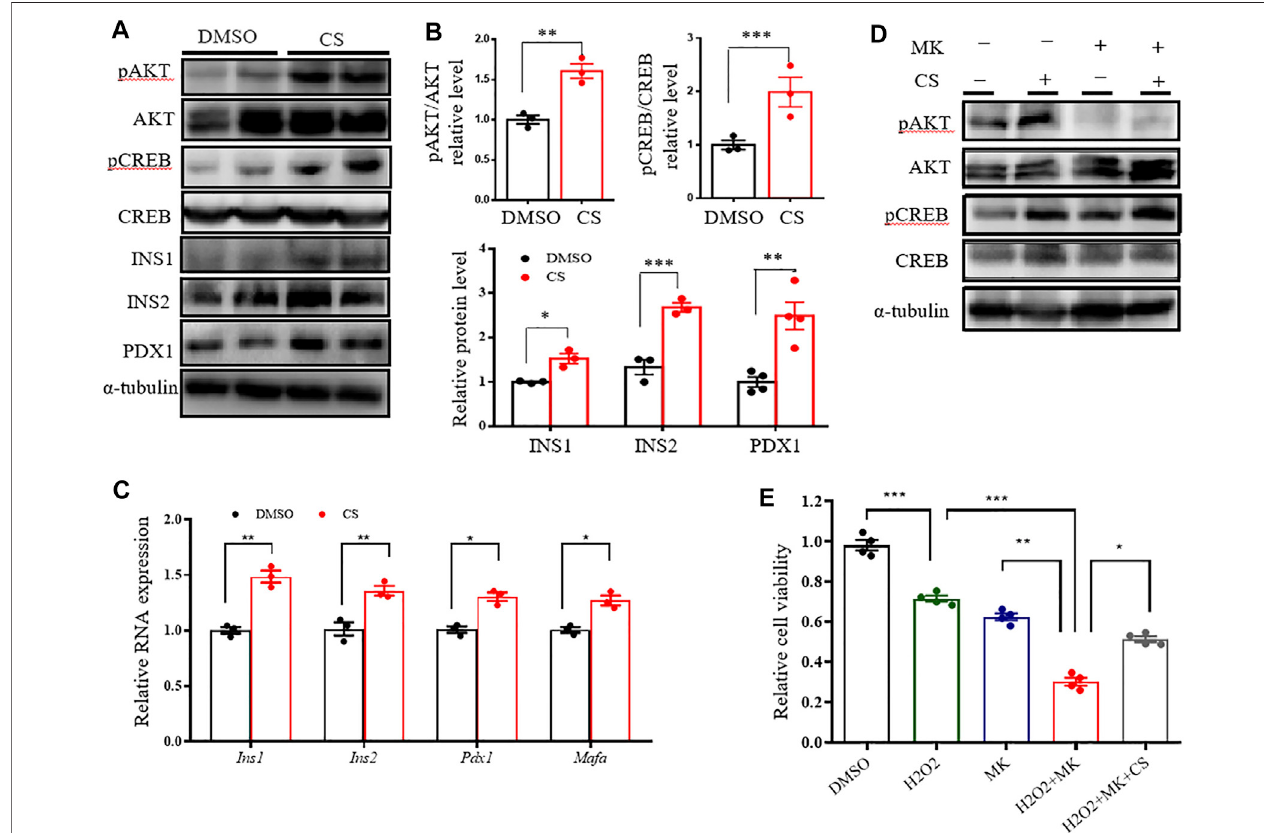
FIGURE4| CSactivatedCREBindependentlyofAKTinINS-1 β -cells. (A – C) INS-1cellswerestimulatedwithDMSOorCS(10 μ M)for12 h.ProteinlevelsofpAKT, AKT, pCREB, CREB, INS1, INS2 and PDX1 were measured by Western blotting (A,B) and mRNA expressions of Ins1 , Ins2 , Pdx1 and Mafa were determined by quantitativePCR (C) . (D) INS-1cellsweretreatedwithCS(10 μ M)for12 hinthepresenceorabsenceofAKTinhibitorMK2206(5 μ M),thelatterwasadded30 minprior toCStreatment.ProteinlevelsofAKTandCREBandtheirphosphorylationweredeterminedbyWesternblotting. (E) INS-1cellswereincubatedwith10 μ